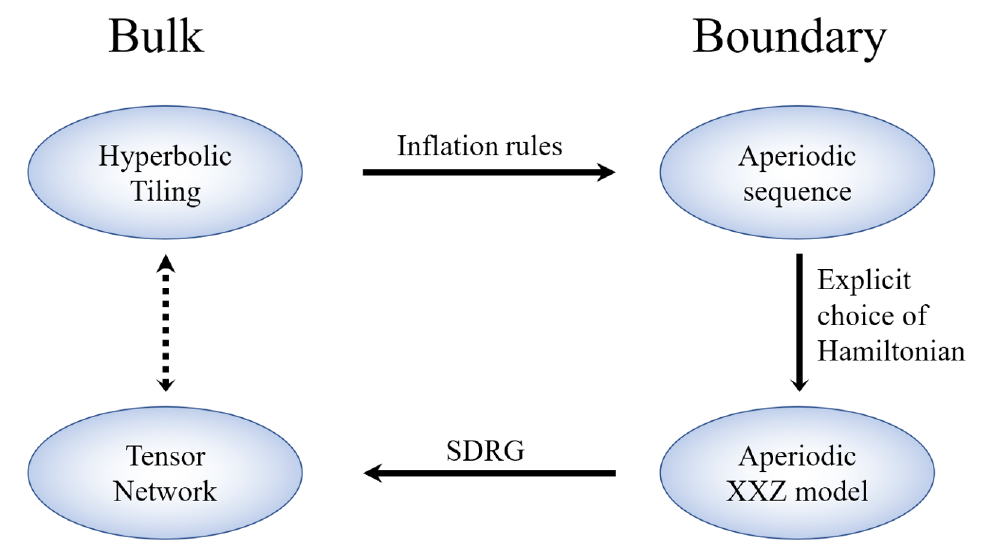
Figure 15: Diagrammatic summary of the relations between hyperbolic tilings, ape- riodic spin chains and tensor networks found in this work. A detailed explanation of the individual ingredients of this diagram is provided in the main